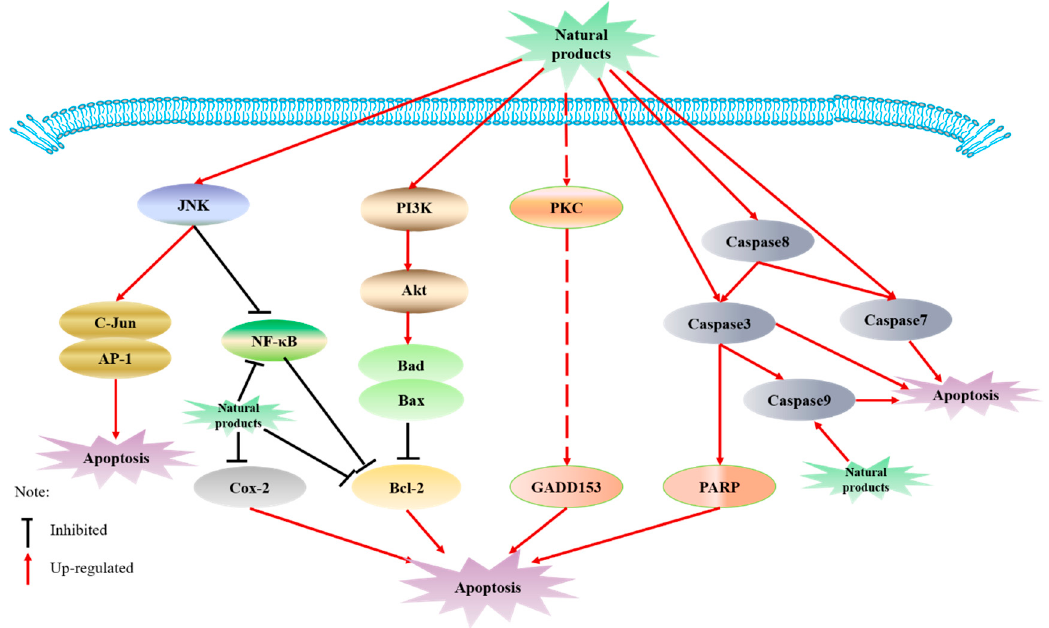
Figure 1. Mechanism of apoptosis.